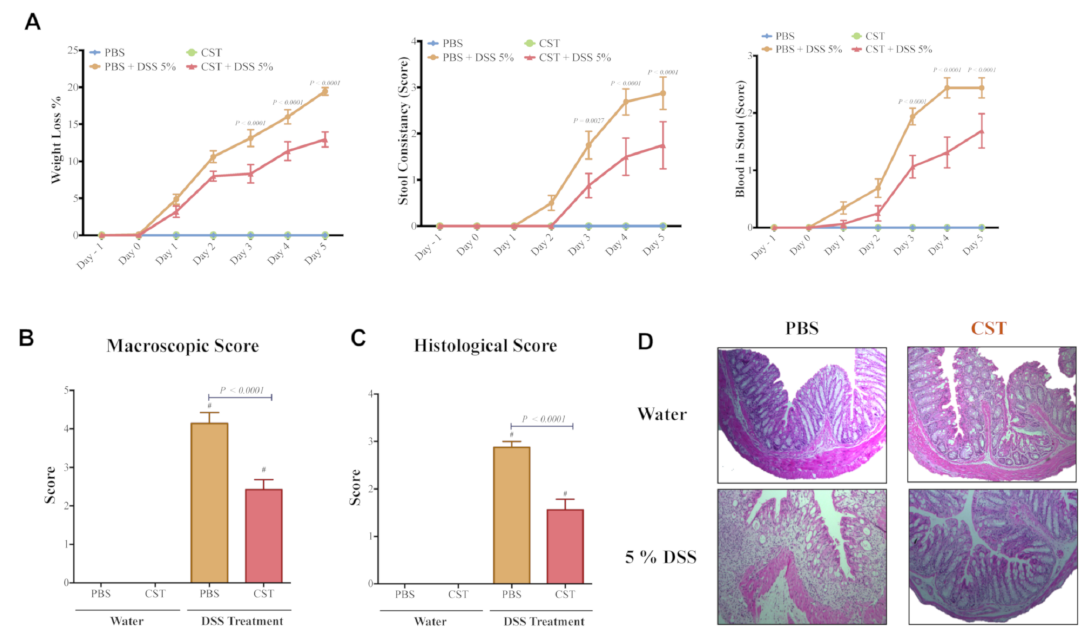
Figure 3. Catestatin (CST) peptide treatment ameliorates DSS-induced colitis. C57BL6 mice were given 5% DSS solution in their drinking water to induce colitis. Control mice received water without dextran sulfate sodium (DSS). Preventive CST (1.5 mg/kg/day) peptides treatment or phosphate buffer saline (1 × PBS) started 1 day before colitis induction and lasted for 5 days. ( A ) Weight loss, stool consistency, and blood in stool; ( B ) macroscopic score; ( C ) histologic scores; and ( D ) hematoxylin and eosin (H&E)-stained colonic sections (100 × magnifications) on day five after administration of DSS and control groups. Two-way repeated measures or One-way ANOVA followed by multiple comparison tests were used to analyze the data. Each value represents the mean ± SEM, n = 7–10 mice/group. # p < 0.0001 compared to control water